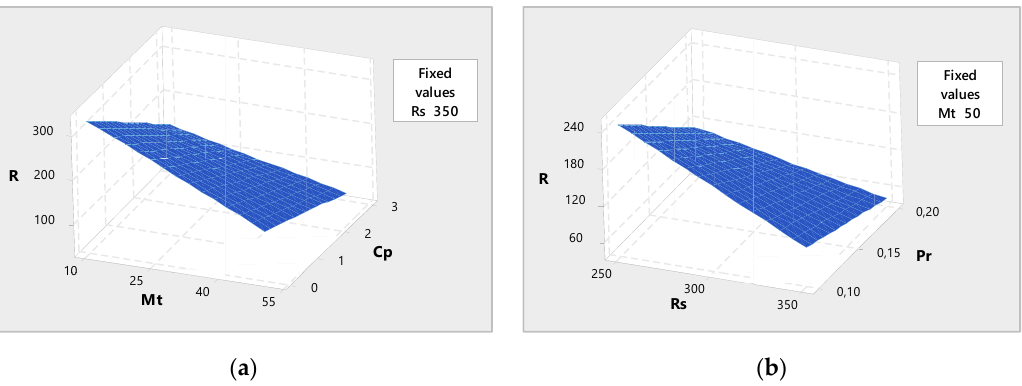
Figure 7. Response surface graphs of particle size: ( a ) milling time versus carbide percentage; ( b ) rotation speed versus powder to ball weight ratio.